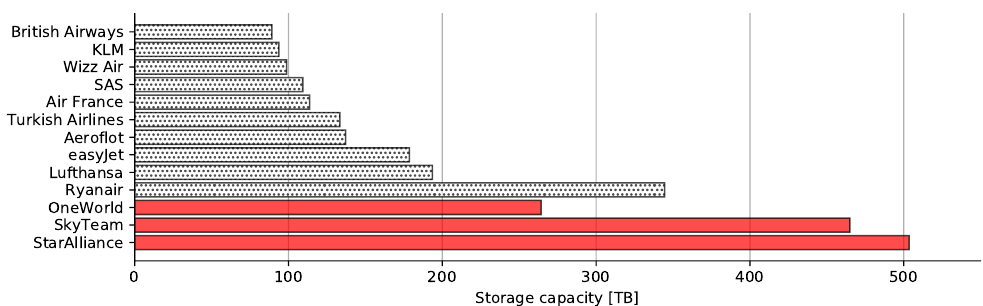
Figure 22. Storage required for storing images of the entirety of Europe by individual alliances and